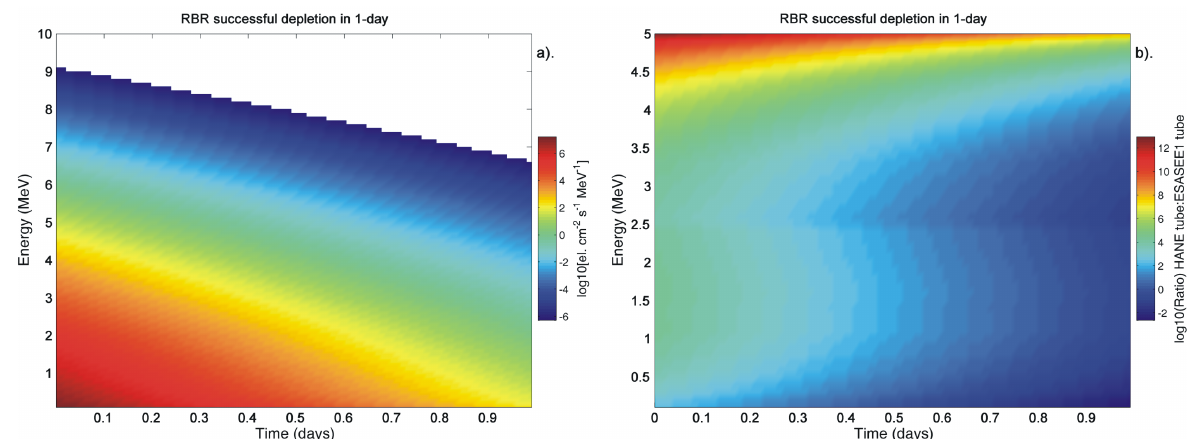
Fig. 4. The changing HANE-injected differential flux at L =1.57 during the operation of the assumed RBR-system. Here the injected population drops to ambient levels at 1MeV in 1 day. a). The changing differential omnidirectional trapped flux. b). The logarithm of the ratio of the differential omnidirectional trapped flux to the ESA-SEE1 predicted ambient